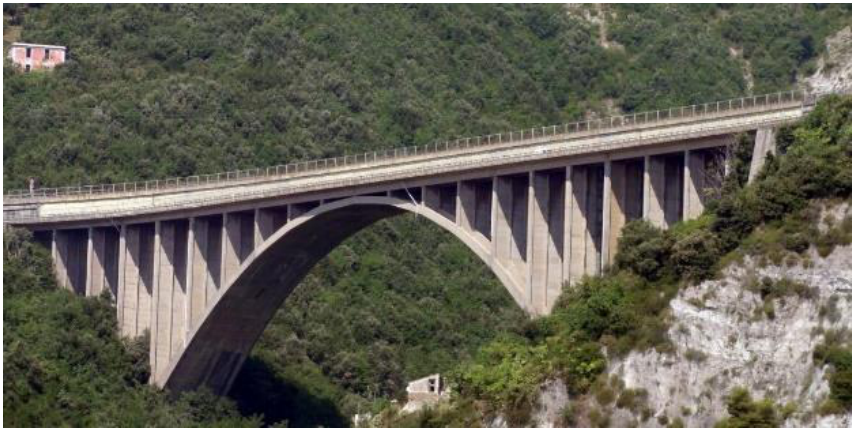
Figure 3. Statistics on the material ( left ) and AINOP classification ( right ) of A3 bridges and viaducts.